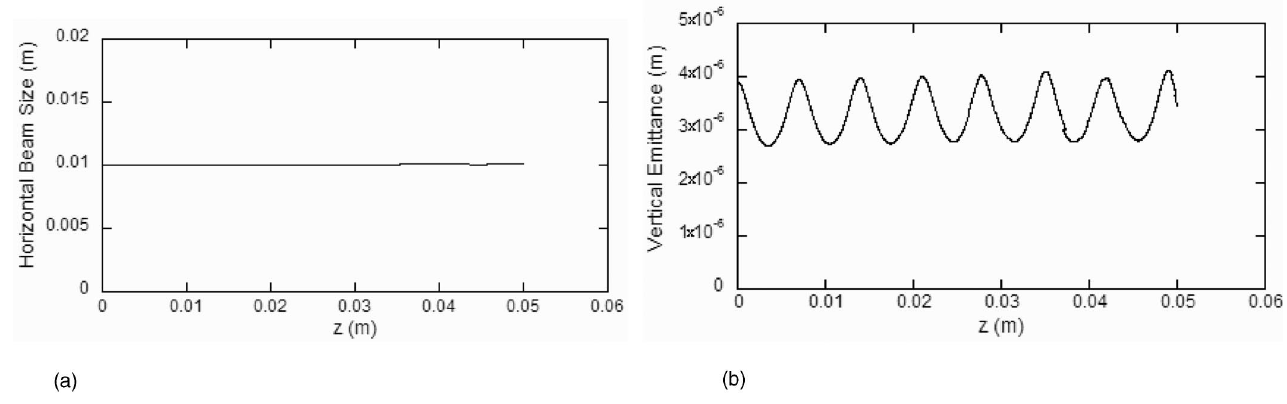
FIG. 11. (a) Horizontal beam size and (b) vertical emittance for a 14-mm